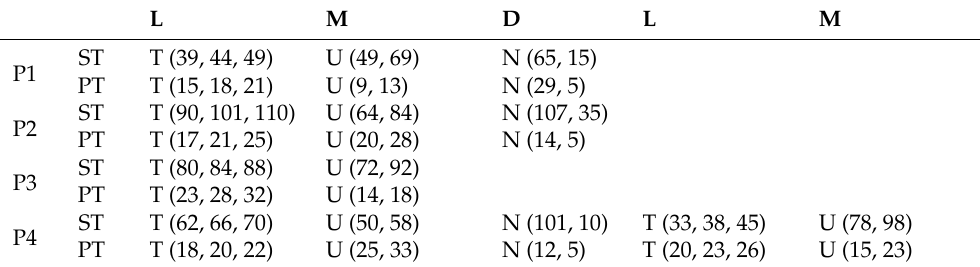
Table 5. Parts’ setup and processing time used for the FMS case study.